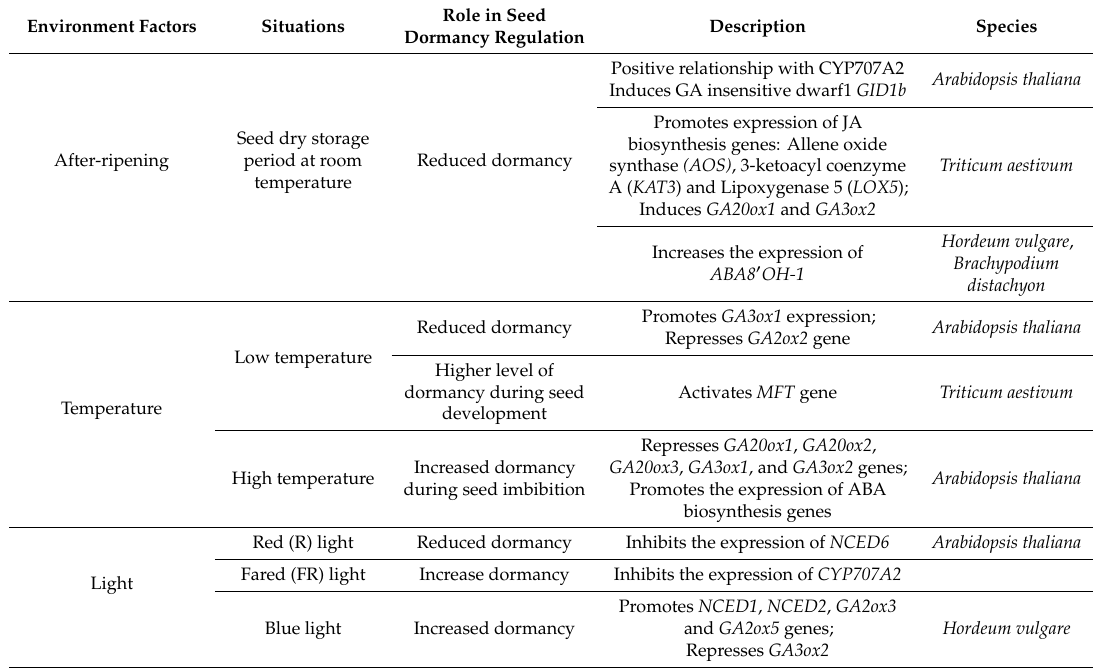
Table 5. Description of Environment factors and their role in seed dormancy regulation in plants reviewed by Skubacz and Daszkowska-Golec